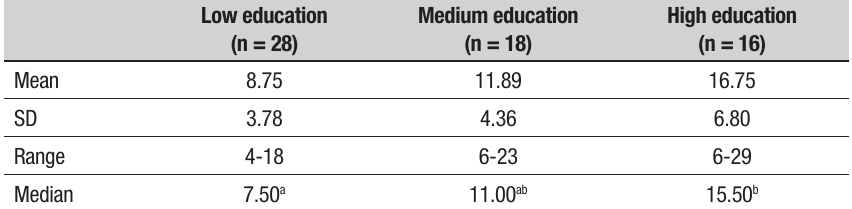
Table 4. Distribution of Verb Fluency results (total score) in Brazilian elderly people according to